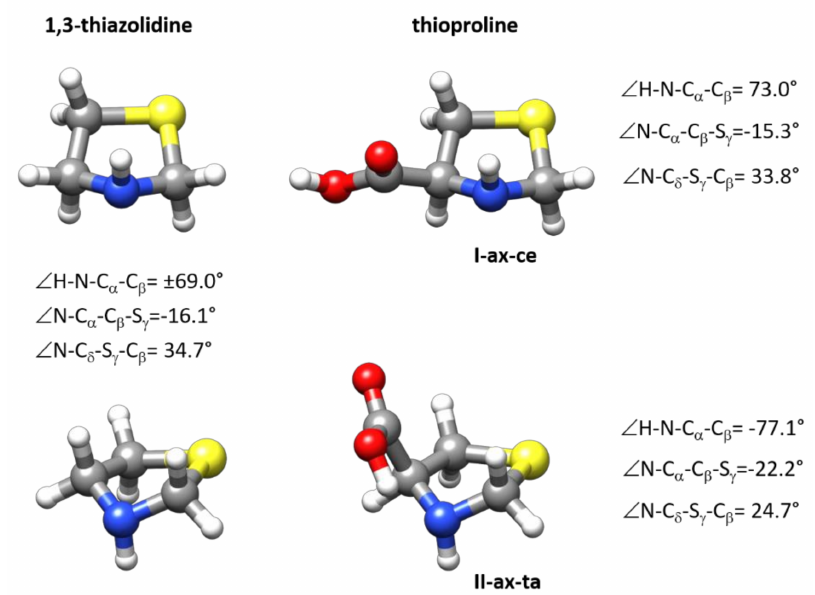
Figure 4. The structures of the two observed forms I-ax-ce and II-ax-ta of SPro are compared to the structure of 1,3-thiazolidine. As can be deduced from the figure these two forms can be interconverted via a concerted movement involving ring puckering and N–H inversion also involved in the inversion of the structure of 1,3-thiazolidine. The figure gives the values of some dihedral angles calculated at MP2/6-311++G(2d,p) level reflecting ring